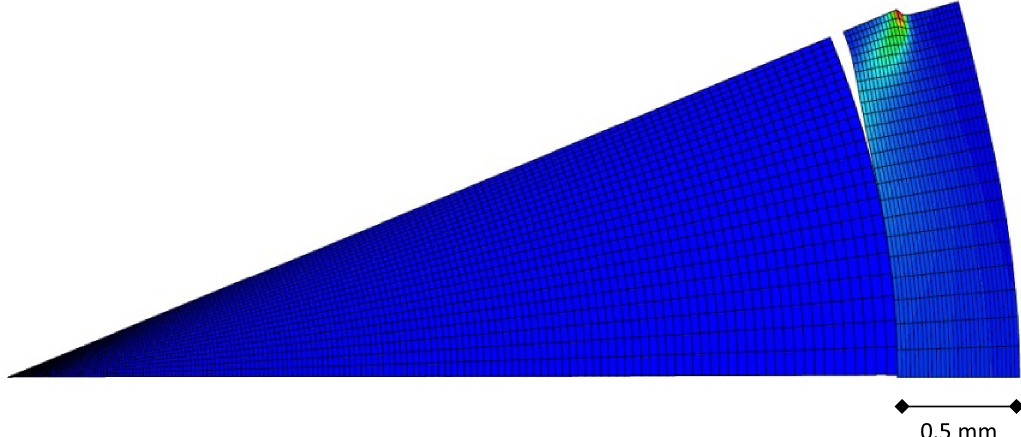
Fig. 4. Local re-opening of the pellet-clad gap during the pulse transient and distribution of the clad equivalent plastic strains (clad displacements are multiplied by a factor 5).